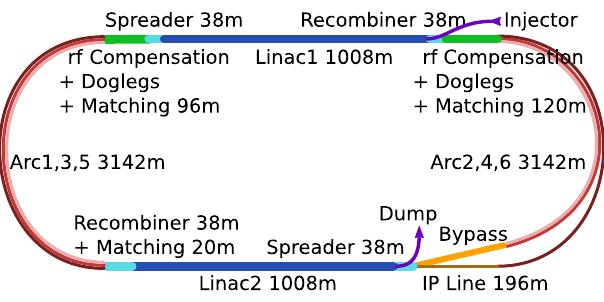
FIG. 1. Scheme of the LHeC electron